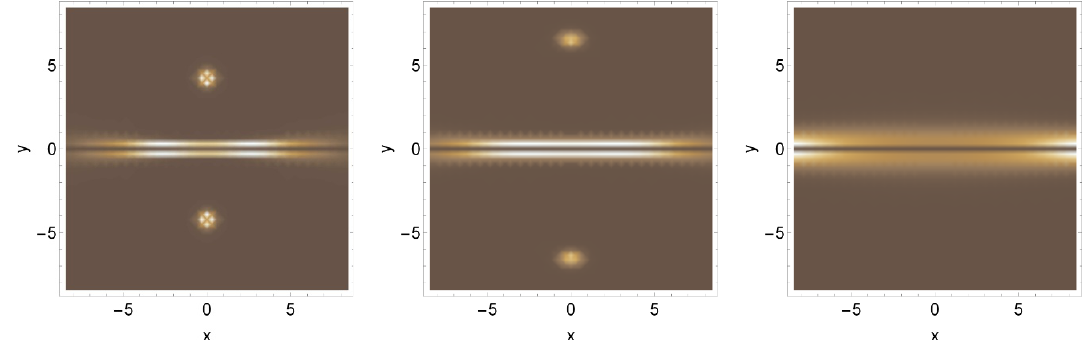
Figure 13 . (color online). (cid:14)(cid:26) in the transverse plane at (a) (cid:28) = 0, (b) (cid:28) = 0 : 4 fm = c, and (c) (cid:28) = 5 fm = c. The value of (cid:14)(cid:26) is multiplied by 10 7 to make the picture more clear. Other parameters n are x = x ? ; (cid:17) = 0 ; ! 1 = 0 : 5 ; ! 2 = 0 : 05 0